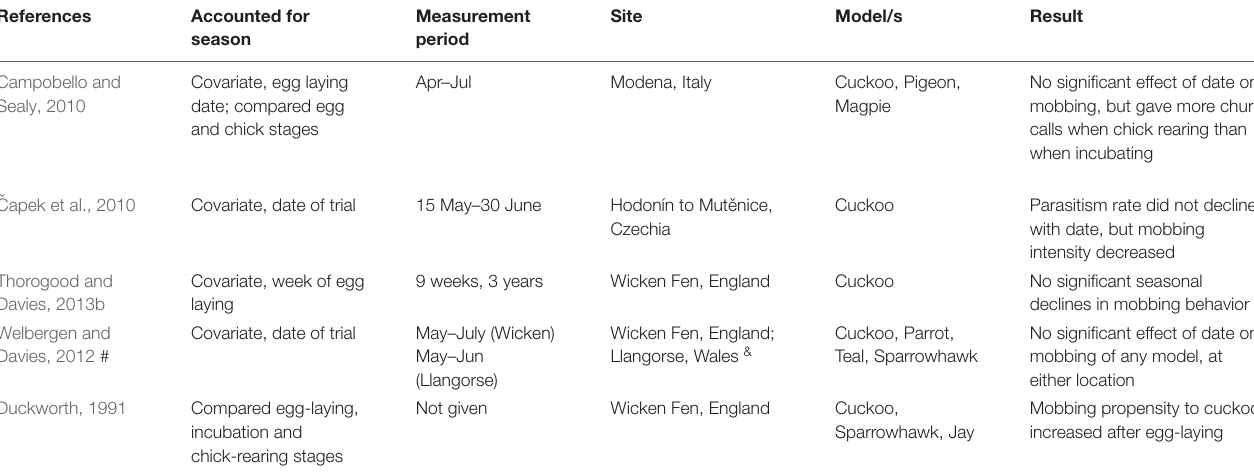
TABLE 1 | Summary of studies with reed warblers, Acrocephalus scirpaceus that included seasonal effects in analyses of mobbing toward cuckoos (other models presented are also shown), or investigated effects of reproductive value via breeding stage.